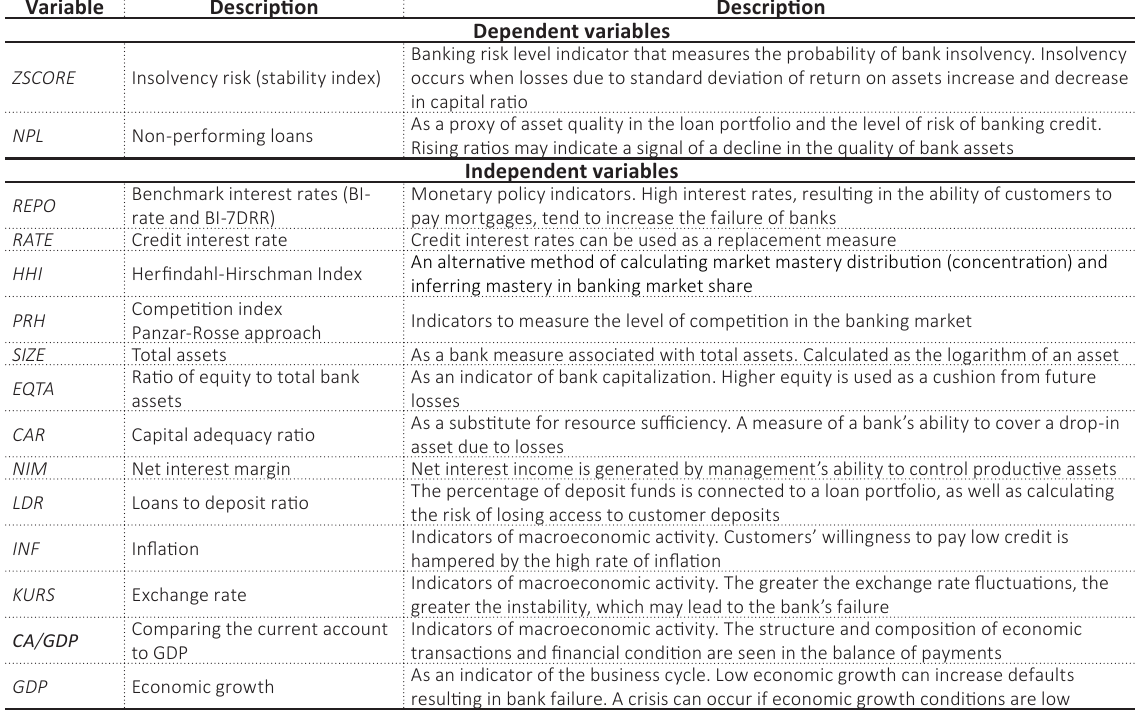
Table 1. Research